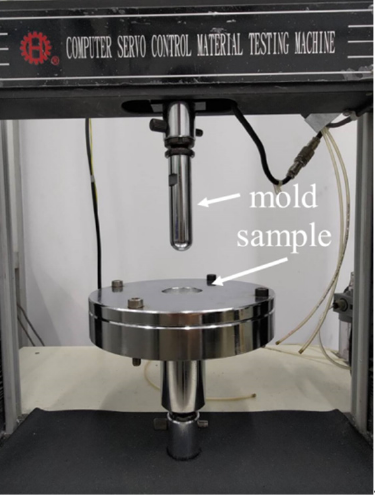
Figure 3. The assembly of bursting strength